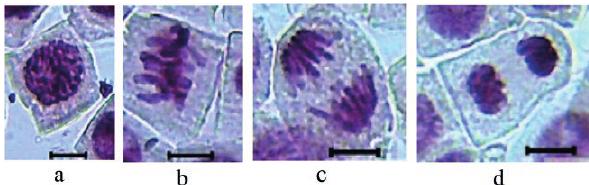
Figure 1. Normal mitosis of A. cepa root tip cells. a. Prophase; b. Metaphase; c. Anaphase; d. Telophase. Scale bar=10μm.